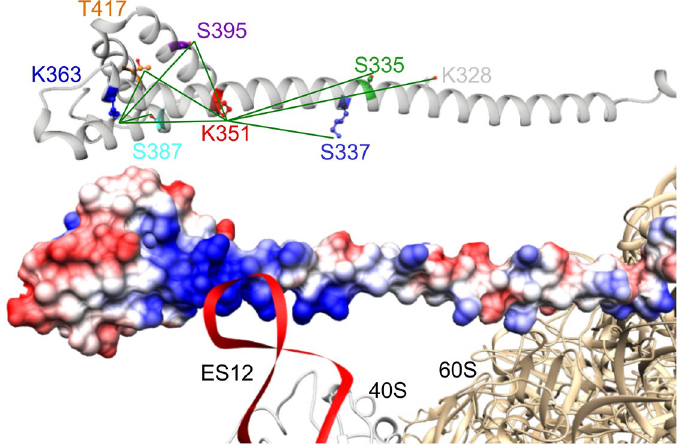
Figure 5. Structural model of Zuo1’s C-terminal region and its interaction with ES12 involving K351. The upper panel shows the modelled middle domain and four-helix bundle of Zuo’s C-terminus in a ribbon presentation (homology model based on PDB 2LWX and 5DJE). Residues used for EPR measurements are shown as colored sticks. Measured distance distributions are indicated by green lines. The lower panel shows the model of Zuo1 C-terminus in a space filling illustration (blue: electropositive surface areas and red electronegative surface area) and its putative interaction with ES12 (red) of the 40 subunit (beige) involving amino acid side chain K351 of Zuo1. The homology model of 4HB is placed with respect to the ribosome structure 25 (PDB 3J78) in the orientation described by Lee et al. 6 (for detail see “Methods”